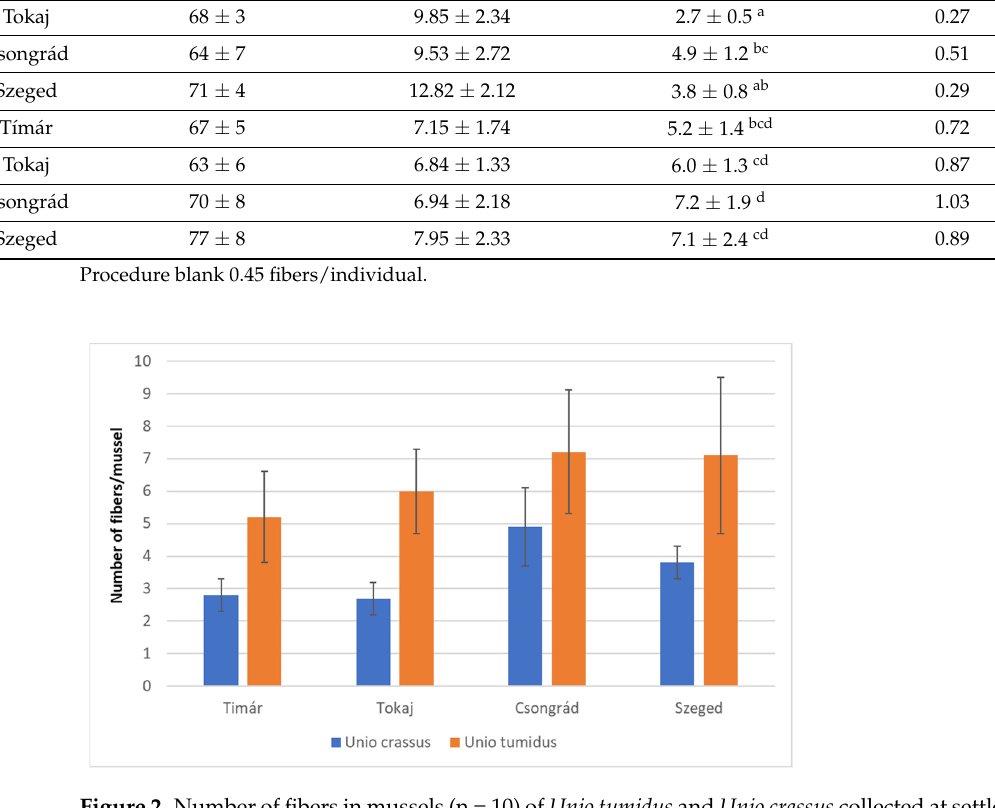
Figure 2. Number of fibers in mussels (n = 10) of Unio tumidus and Unio crassus collected at settlements of Tímár, Tokaj, Csongrád, and Szeged. The standard deviations are marked on the bars.